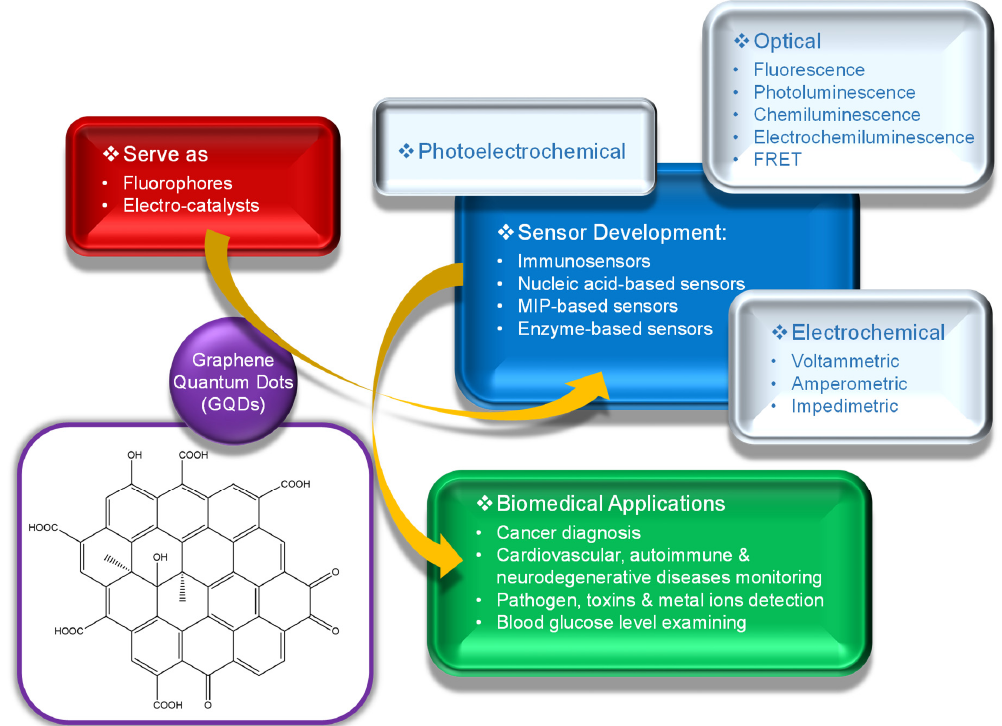
Figure 1. The chemical structure of graphene quantum dots (GQDs) and their biomedical applications in sensor development.